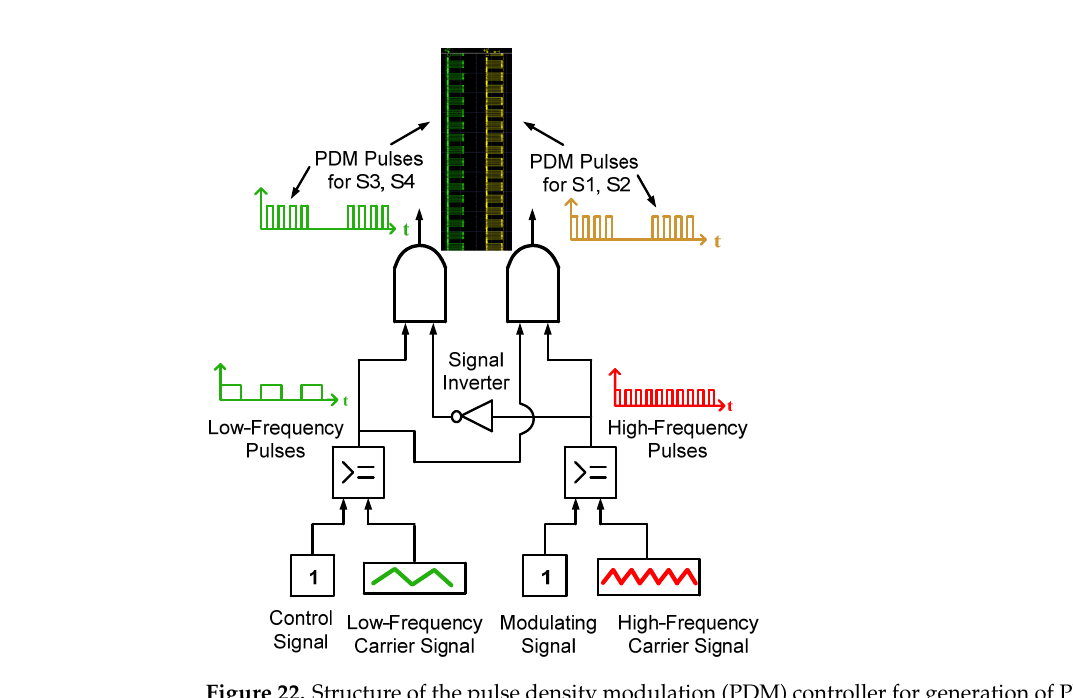
Figure 22. Structure of the pulse density modulation (PDM) controller for generation of PWM pulses.